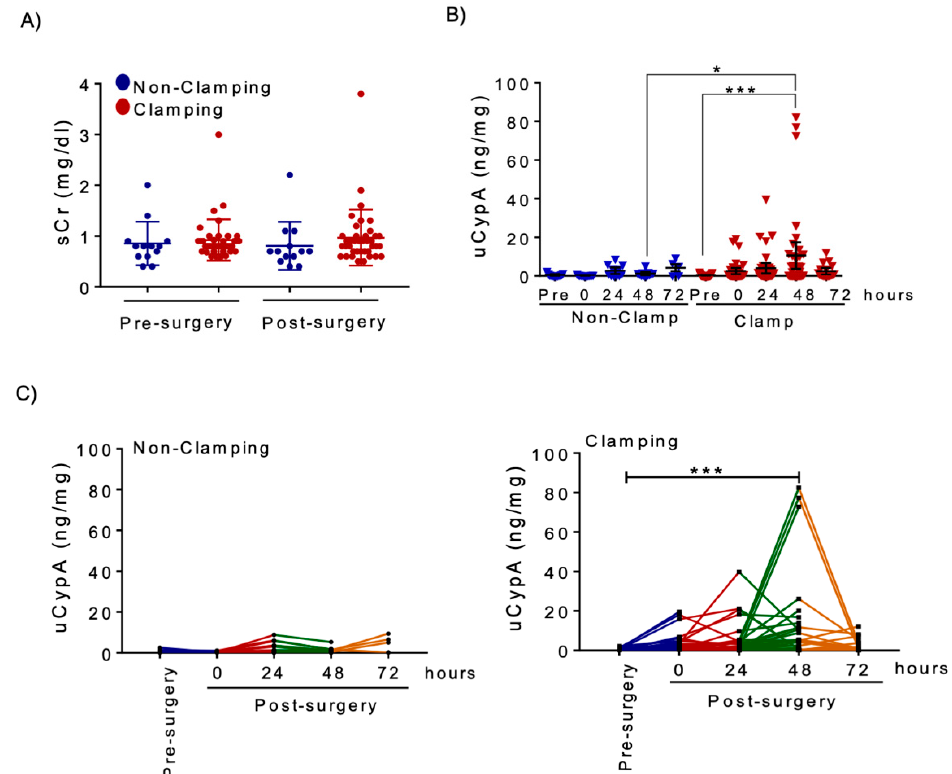
Figure 5. uCypA levels are increased in NSS patients with renal artery clamping but not in patients without clamping. ( A ) sCr levels after surgery did not differ between clamping and non-clamping patients. ( B ) uCypA levels are increased after surgery in NSS patients with clamping. Bars represent mean ± SEM. * p < 0.05; *** p < 0.001. ( C ) Time course of uCypA levels in individual patients shows a peak at 24–48 h after surgery in most clamping patients, while no clear peak was observed in non-clamping patients. ( B , C ) uCypA is expressed as urinary CypA: urinary creatinine ratio.